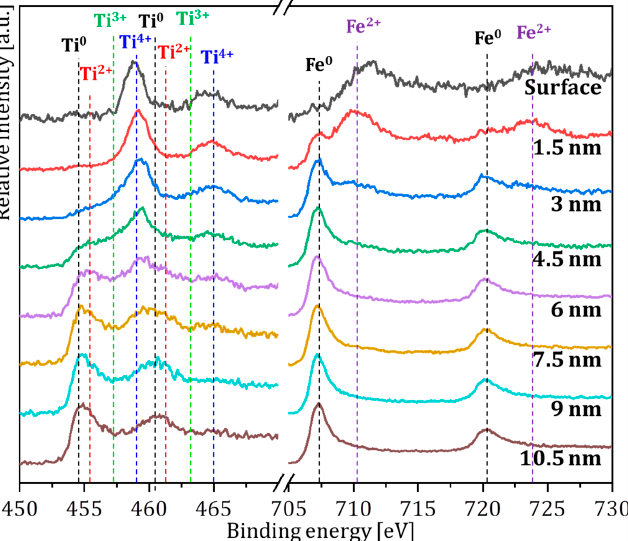
Figure 2. X-ray photoelectron spectroscopy (XPS) depth profile of the reference TiFe sample.